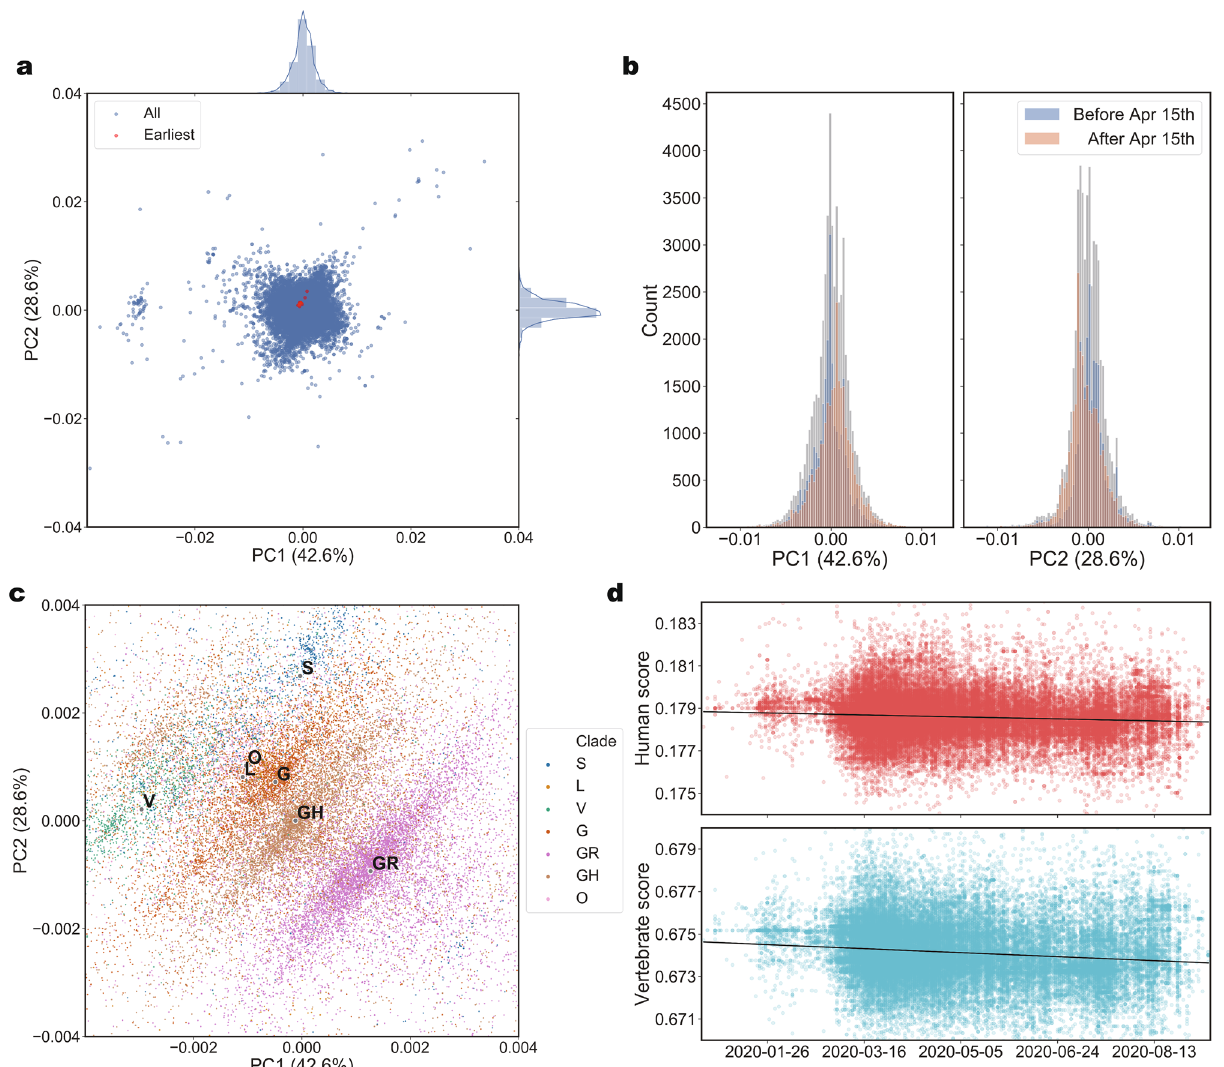
Figure 4. Entirety and divergence in the host likelihood score profiles of 53,759 SARS-CoV-2 isolates in the later world-wide pandemic. ( a ) PCA of host likelihood score profiles of 53,759 SARS-CoV-2 isolates and the distribution on each principal component. All the host likelihood score profiles of 53,759 SARS-CoV-2 isolates were clustered with 17 earliest sequenced isolates located in the center and the density curves displayed on each principal component were approximate normal distribution. ( b ) Distributions of host likelihood score profiles of 53,759 SARS-CoV-2 isolates collected before and after 15 April 2020. When the SARS-CoV-2 isolates were divided chronologically using 15 April 2020 as the split date, which divided the 53,759 isolates into two parts more evenly than other dates. The host likelihood score profiles of SARS-CoV-2 before and after 15 April 2020 had divergent distributions on each principal component (two-sided two-sample Kolmogorov–Smirnov test, p value = 0, n isolates = 26,167 before 15 April 2020 and 27,592 after 15 April 2020. Blue, 26,167 isolates collected before 15 April 2020; Red, 27,592 isolates collected after 15 April 2020; Grey, all the 53,759 isolates). ( c ) GISAID clades represented in PCA of host likelihood score profiles of 53,759 SARS-CoV-2 genomes. All the 53,759 samples representing 53,759 host likelihood score profiles were painted with six different colours corresponding to six different GISAID clades of SARS-CoV-2. SARS-CoV-2 isolates fell into several clear fusiform clusters with different colours according to their clades. ( d ) Time series of the host likelihood scores on humans and non- human vertebrates for SARS-CoV-2 in the later world-wide pandemic. The host likelihood scores on humans and non-human vertebrates descend gradually with time (linear regression model analysis, R -squared = 6.806 × 10 –3 and 1.431 × 10 −2 , t × 10 –84 and 3.292 × 10 –272 , (53,757) = − 19.22 and t (53,757) = − 27.96, p values = 5.543 slopes = − 1.853 × 10 –6 and − 3.768 × 10 –6